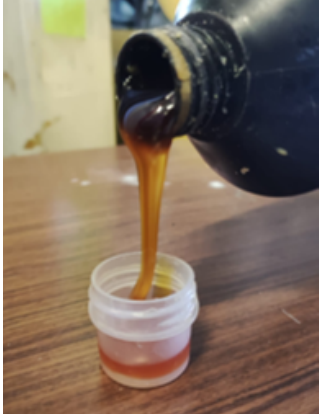
Figure 2. Bio-adhesive supplied for this